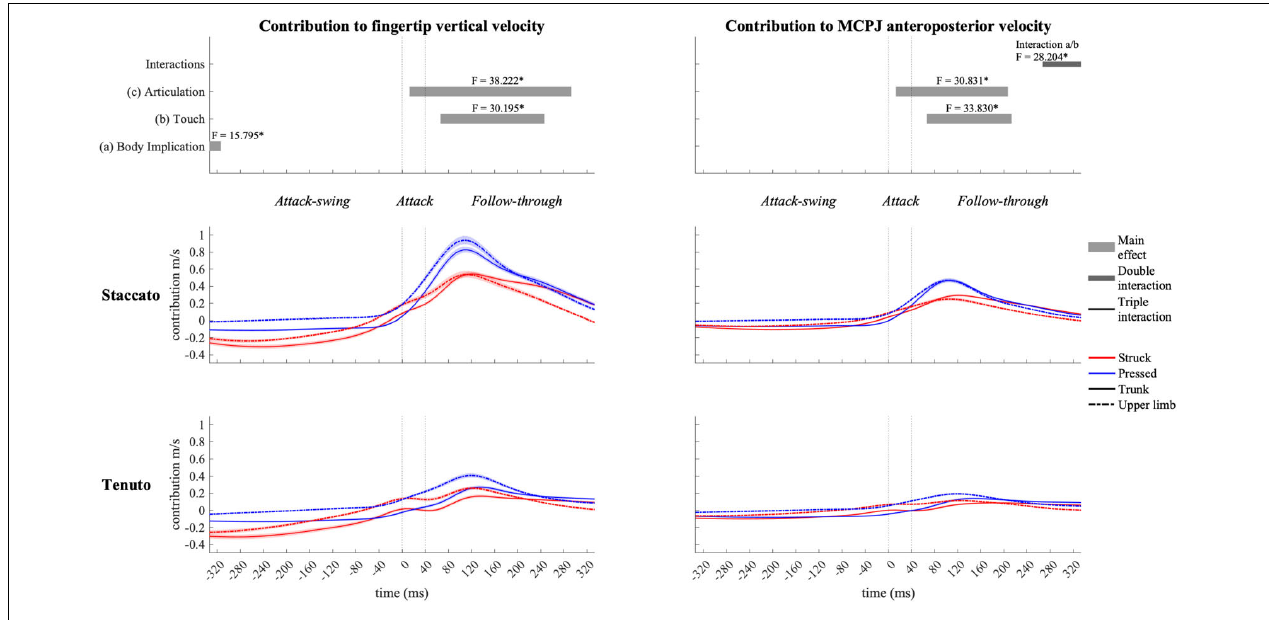
FIGURE 10 | Mean values (solid and dash-dotted lines) and 95% bootstrap confidence interval (shaded areas) of shoulder-girdle-joint angular contribution to endpoint velocities during the three phases of the keystroke. Negative/positive values indicate contributions to downward/upward fingertip velocities and to backward/forward metacarpophalangeal joint (MCPJ) velocities. Top panels represent the results from the statistical parametric mapping of time-series values. * p -value ≤ 0.001.